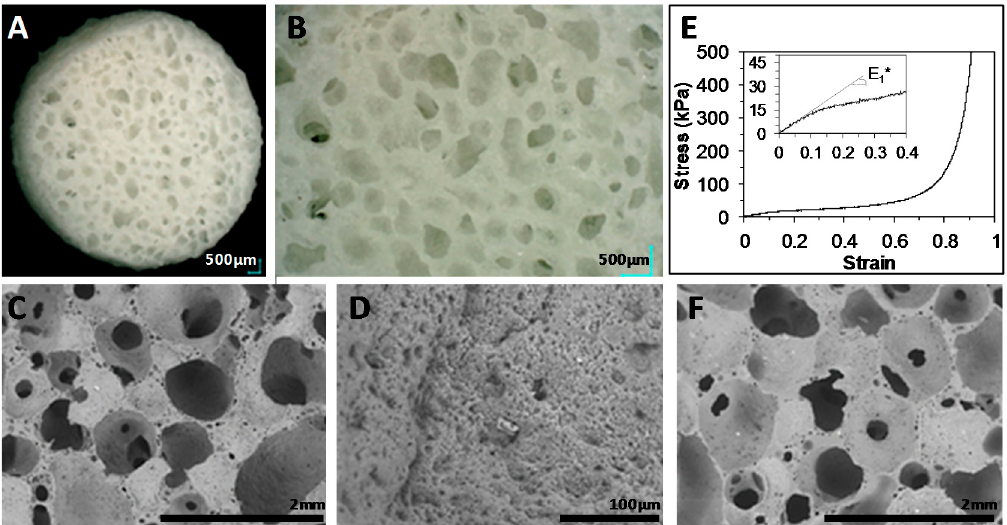
Figure 1. ( A , B ): Digital microscope images of functionalized-poly(ester-urea-urethane) scaffolds (PEUUF) scaffolds. ( C , D ): Environmental scanning electron microscope (ESEM) images of PEUUF scaffolds. E : Mechanical behavior of PEUUF scaffolds under stress modes of compression. F : ESEM image of PEUUF scaffolds after 7 months of incubation at 37 °C in the degradation medium. The low-molecular-weight (LMW) fucoidan concentration in the aqueous phase (34 mL) of the High Internal Phase Emulsion (HIPE) used for functionalization = 10 mg mL ‒ 1 ).